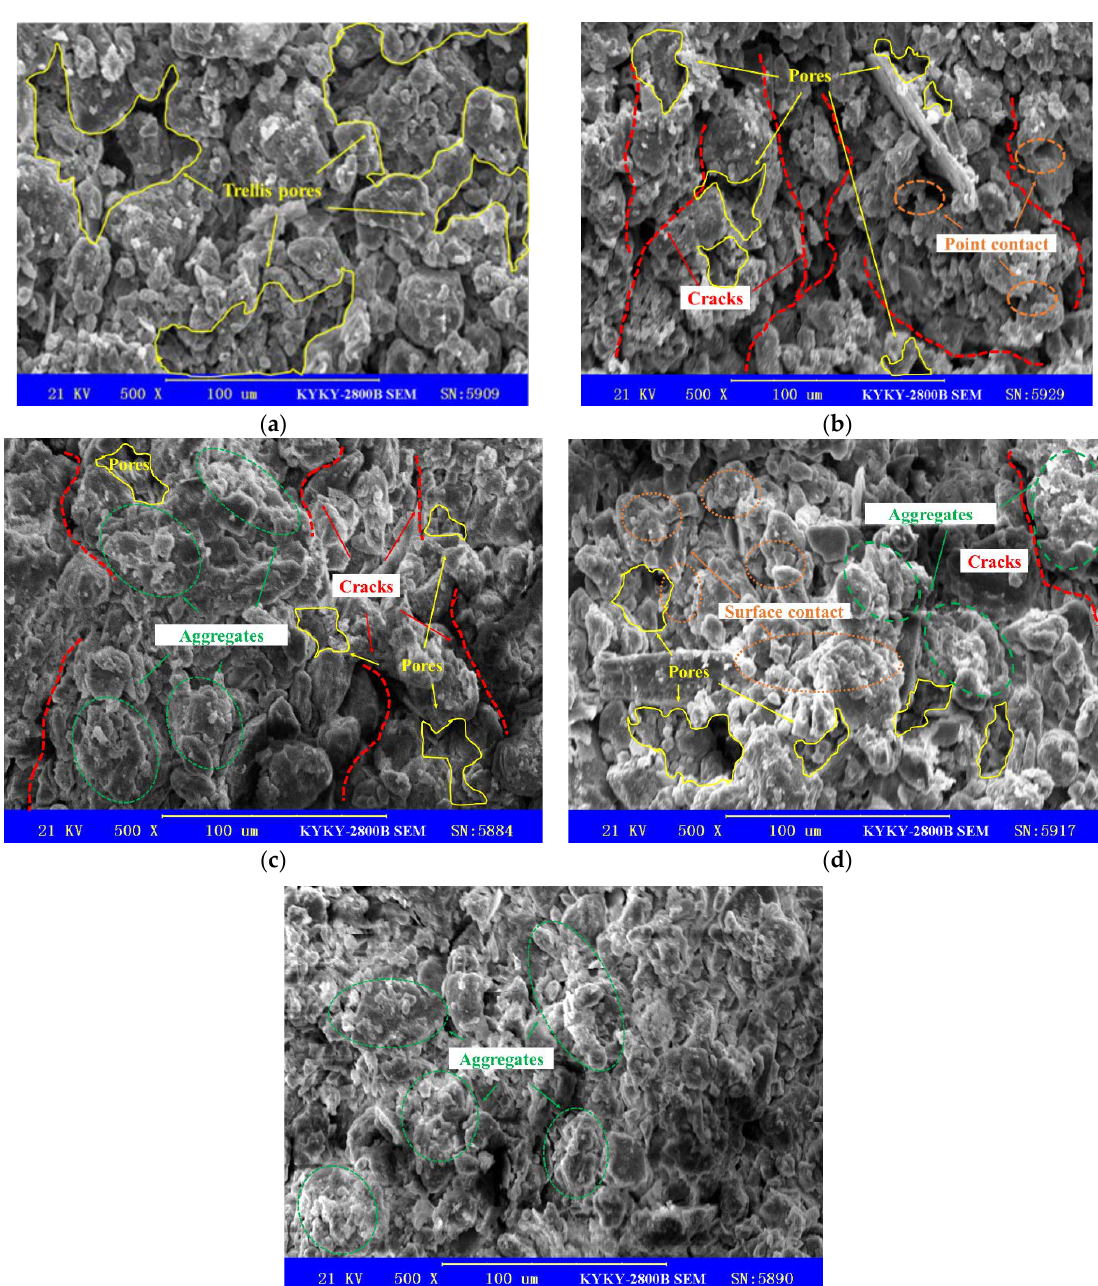
Figure 15. Microstructure characteristics of the saturated loess under different test conditions: ( a ) the original saturated loess with OCR = 1, ( b ) the aftershock loess with OCR = 1, ( c ) the aftershock loess with OCR = 2, ( d ) the aftershock loess with OCR = 3, and ( e ) the aftershock loess with OCR = 4.